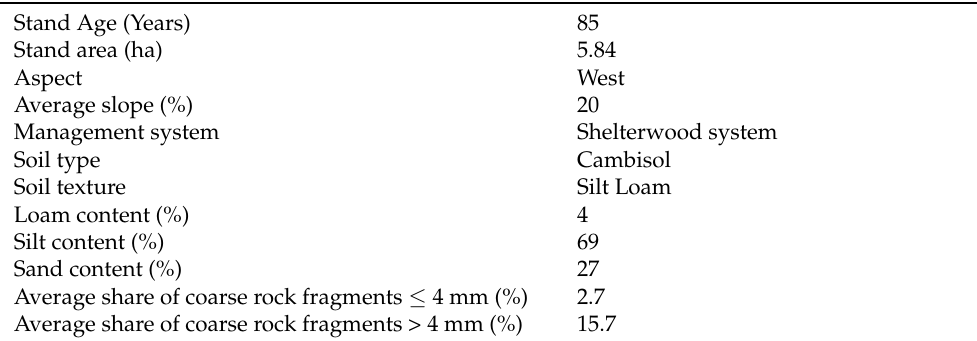
Table 1. Basic data about the forest stand no. 544 extracted from the forest management plan and soil parameters [17].